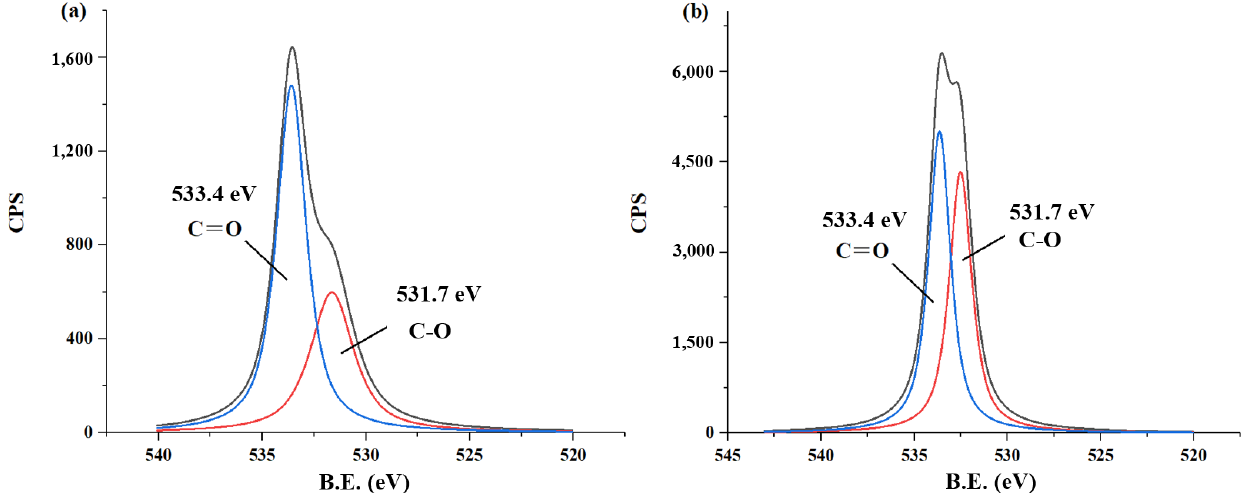
Figure 2. Detailed analysis of the O 1s profile of XPS results of ( a ) GO and ( b ) HBP-m-GO.